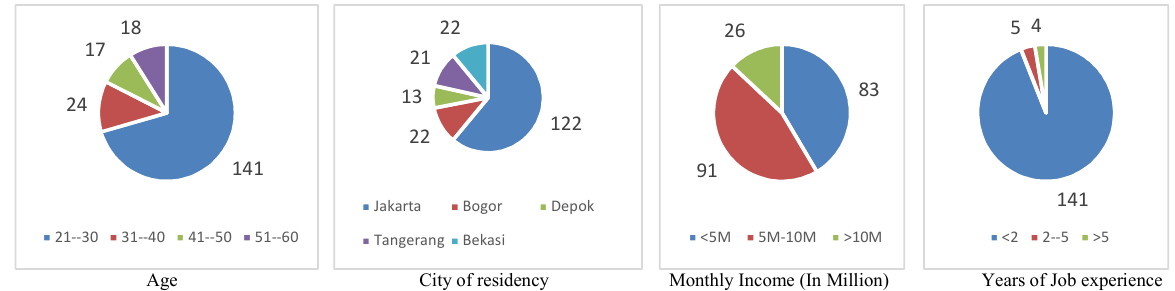
Fig. 2. Personal characteristics of the participants